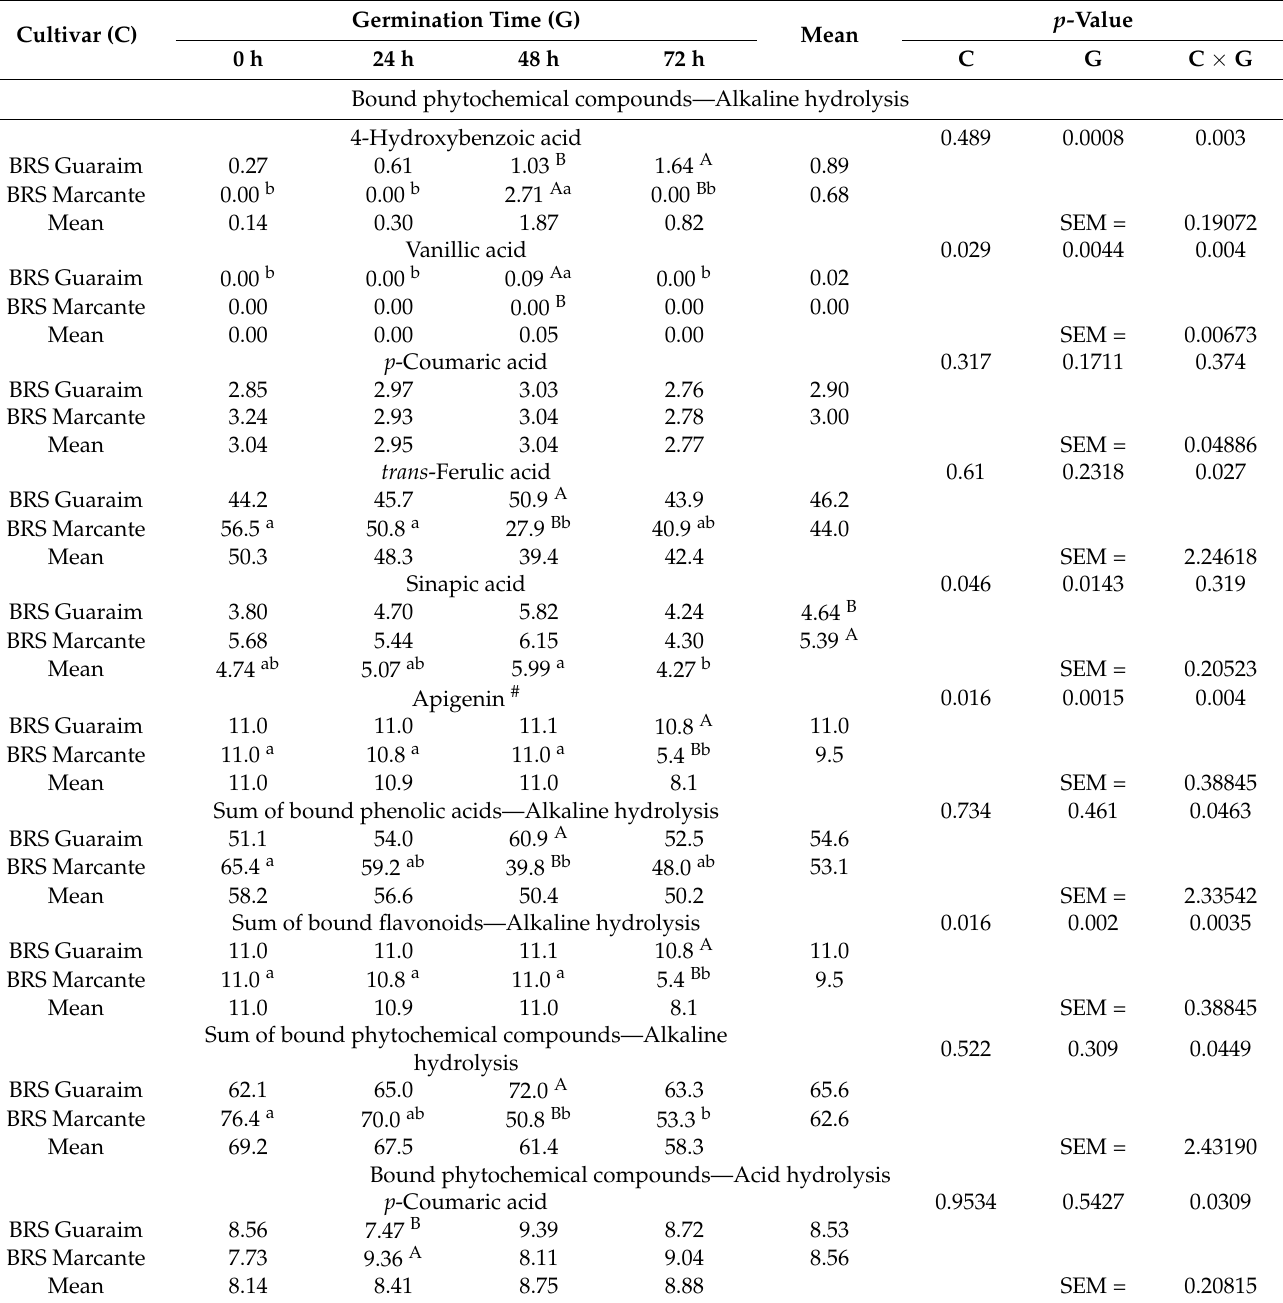
Means (n = 6) followed by different capital letters within the same column and different small letters within the same row differ ( p < 0.05), respectively, between cultivars and germination times using the Student–Newman– Keuls test. # Flavonoids were quantified as equivalent to quercetin. LoQ: limit of quantification; SEM: standard error of mean. 4-Hydroxybenzoic acid LoQ: 0.062; Vanillic acid LoQ: 0.025 ppm; p -Coumaric acid LoQ: 0.029 ppm; trans -Ferulic acid LoQ: 0.033 ppm; Sinapic acid LoQ: 0.258 ppm; Quercetin LoQ: 0.444